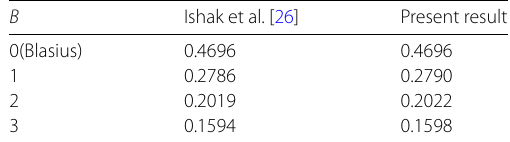
Table 1 Comparison of skin friction f (cid:2)(cid:2) (0) when P r = 1 for different B with existing